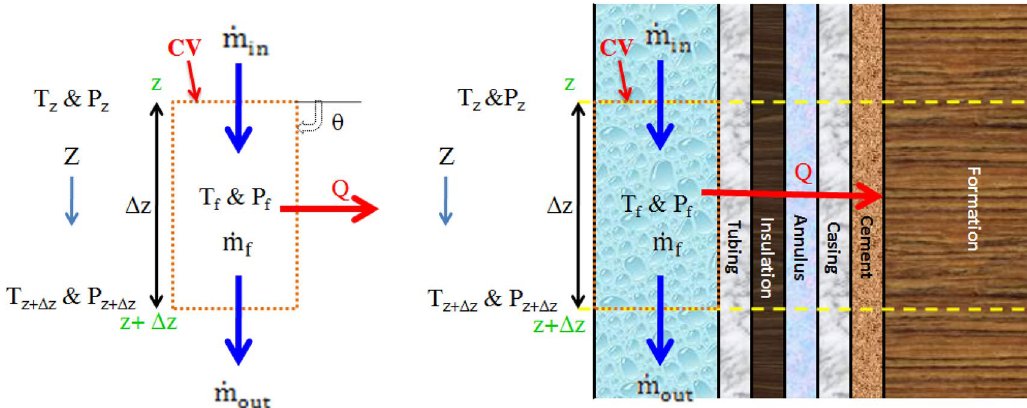
Fig. 2 A schematic of control